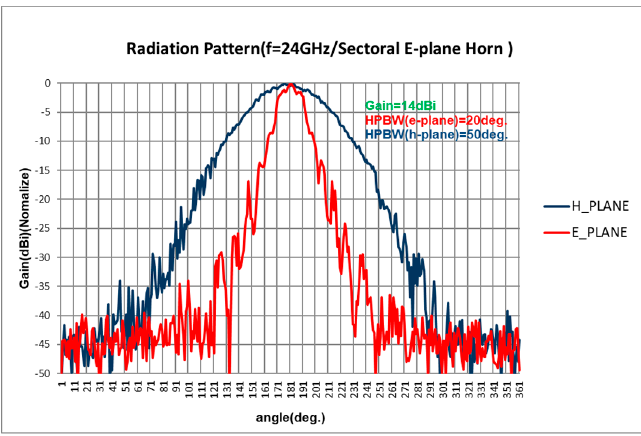
Figure 7. Measured Rx E-plane sectoral horn antenna radiation pattern (normalized).